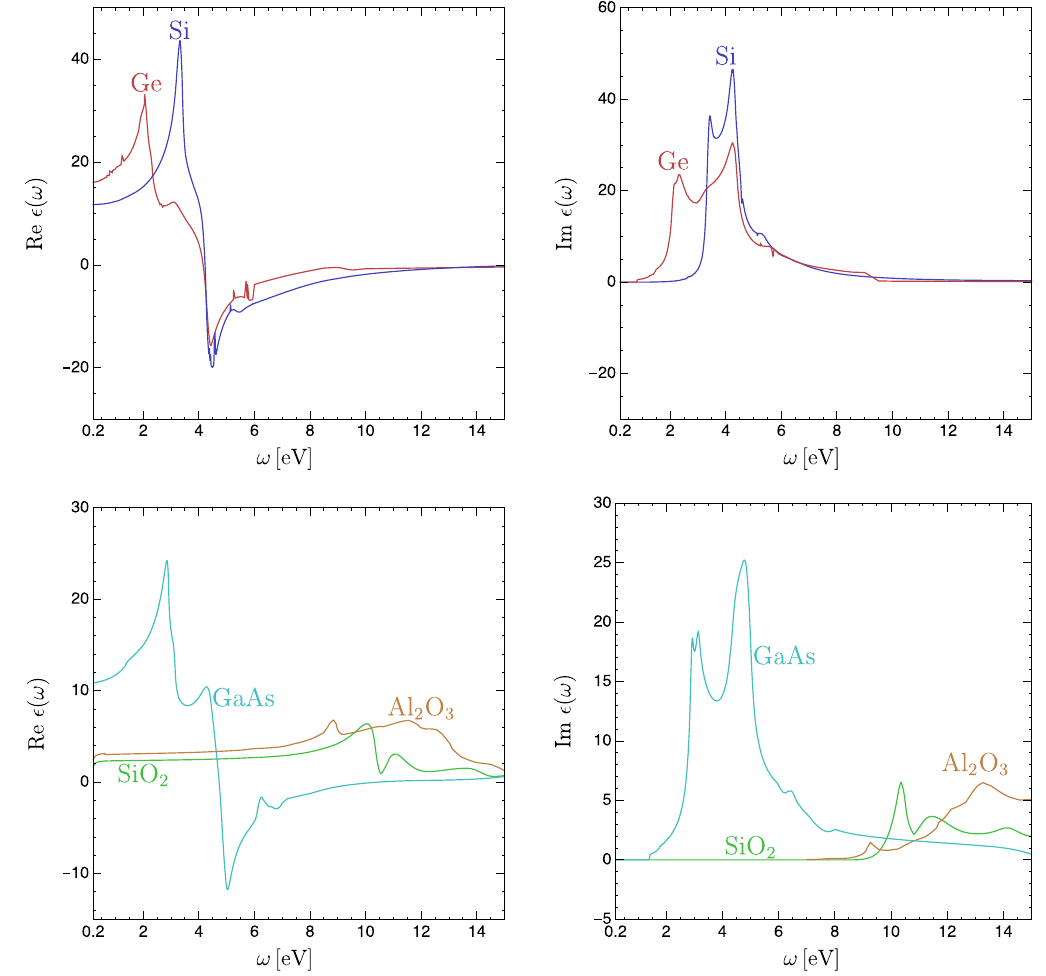
FIG. 3. Real and imaginary parts of the dielectric functions of Ge and Si (top) and of the polar materials α -quartz, sapphire, and GaAs (bottom), in the range of photon energies 0 . 2 ≤ ω ≤ 15 eV. For the case of sapphire and α -quartz, we show the dielectric function for the ordinary ray. All data are at room temperature. Data for Si, Ge, α -quartz, and GaAs are obtained from Ref. [114]. Data for sapphire are obtained from Refs.